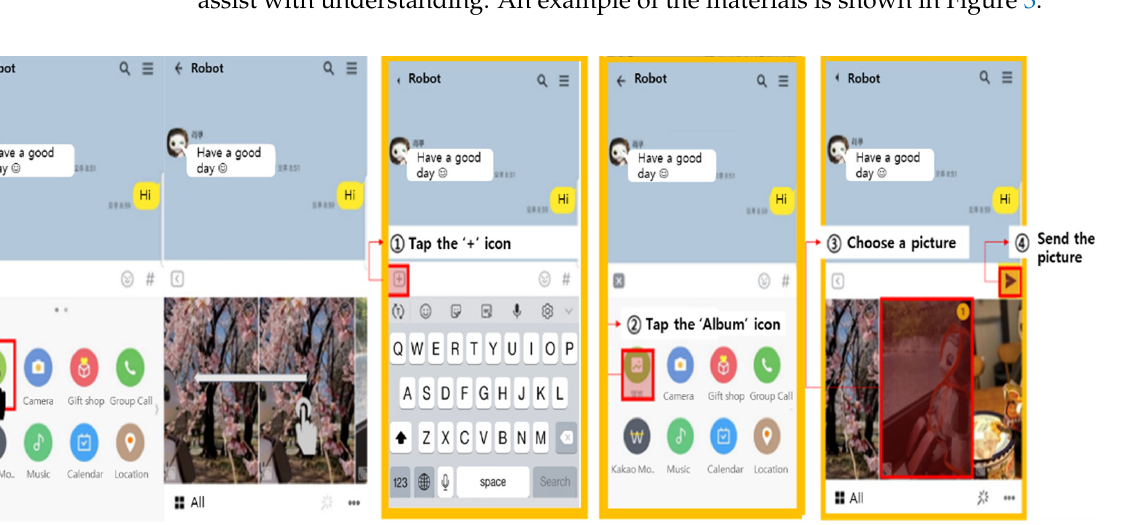
Figure 3. Training materials indicating how to find and share a picture.